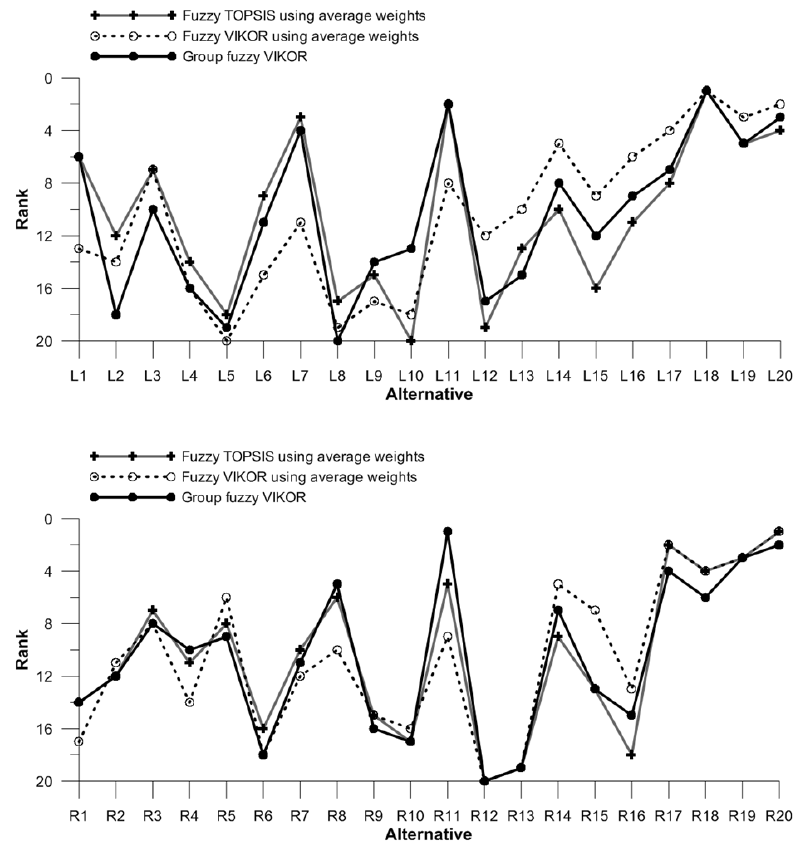
Figure 9. Comparison of assessed ranks by group fuzzy MCDM and typical MCDM